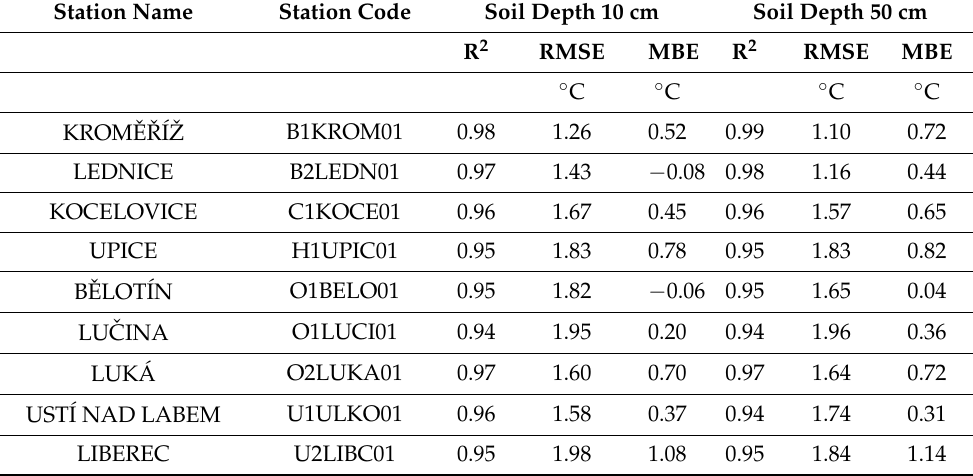
Table A2. Statistical validation results of AGRISOTES (measured vs. simulated soil temperatures) for nine validation sites (see Table A1) in the Czech Republic (related to Figures A1–A18).